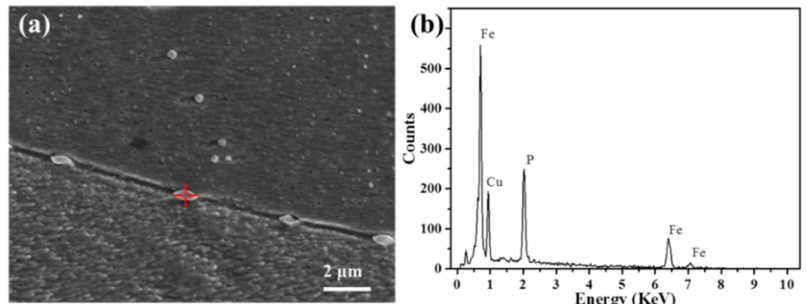
Figure 4. ( a ) An enlarged SEM image of the enclosed area with dotted lines in Figure 3c and ( b ) energy dispersive spectrometer (EDS) analysis of particles in ( a ).